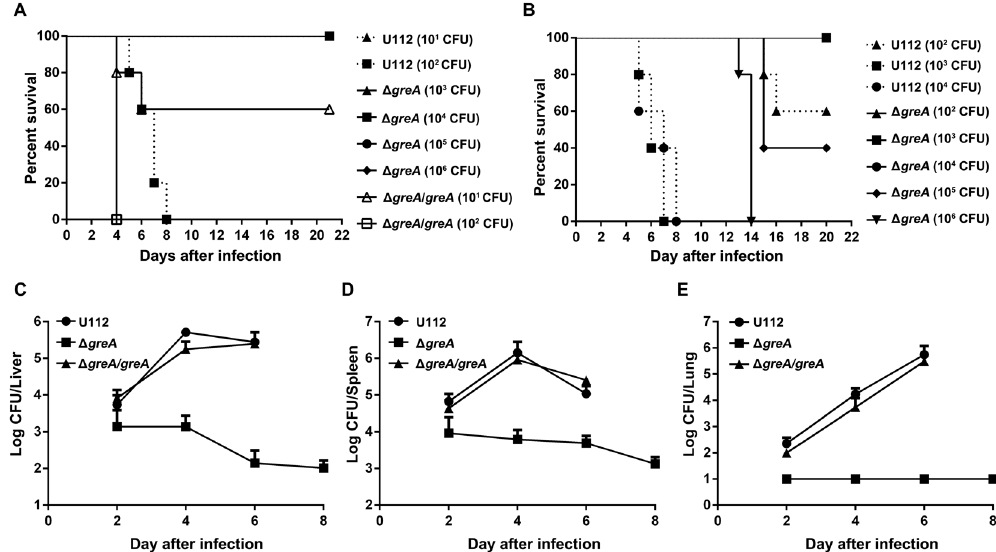
Figure 4. Impact of greA deletion on the in vivo growth and pathogenicity of F. novicida . ( A,B ) Survival of mice infected intranasally (n = 5) ( A ) or subcutaneously (n = 5) ( B ) with different doses of wild-type strain U112 or its derivatives. ( C–E ) Growth of wild-type strain U112 and its derivatives in the livers ( C ), spleens ( D ), and lungs ( E ) of mice after subcutaneous infection with doses of 10 3 CFU/mouse of the wild-type strain U112 or Δ greA / greA , or 3 × 10 5 CFU/mouse of the Δ greA mutant. All values are mean log CFU/organ ± SD (n = 5). p < 0.05 compared with the Δ greA group, based on log-transformed data at all time points. The experiment was repeated once. Statistical significance was determined by one-way analysis of variance (ANOVA)